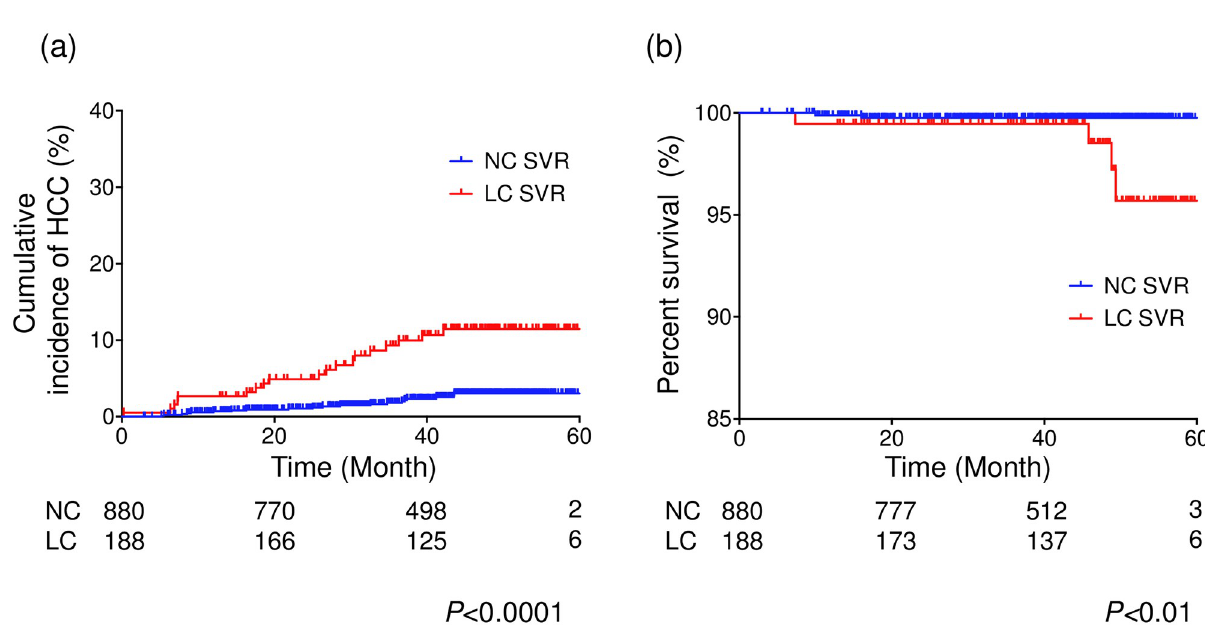
Fig 2. Comparison of the cumulative hepatocellular carcinoma incidence and liver-related survival rate between hepatitis C patients without cirrhosis (NC) and those with compensated liver cirrhosis (LC). (a) Cumulative incidence of hepatocellular carcinoma in patients with compensated liver cirrhosis (red line) and patients without cirrhosis (blue line). (b) The liver-related survival rate of patients with compensated liver cirrhosis (red line) and patients without cirrhosis (blue line). The results were analyzed with the log-rank test.